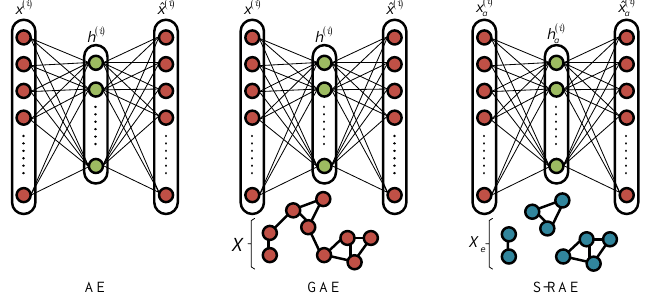
Figure 2. Comparison of AE, GAE, and our proposed